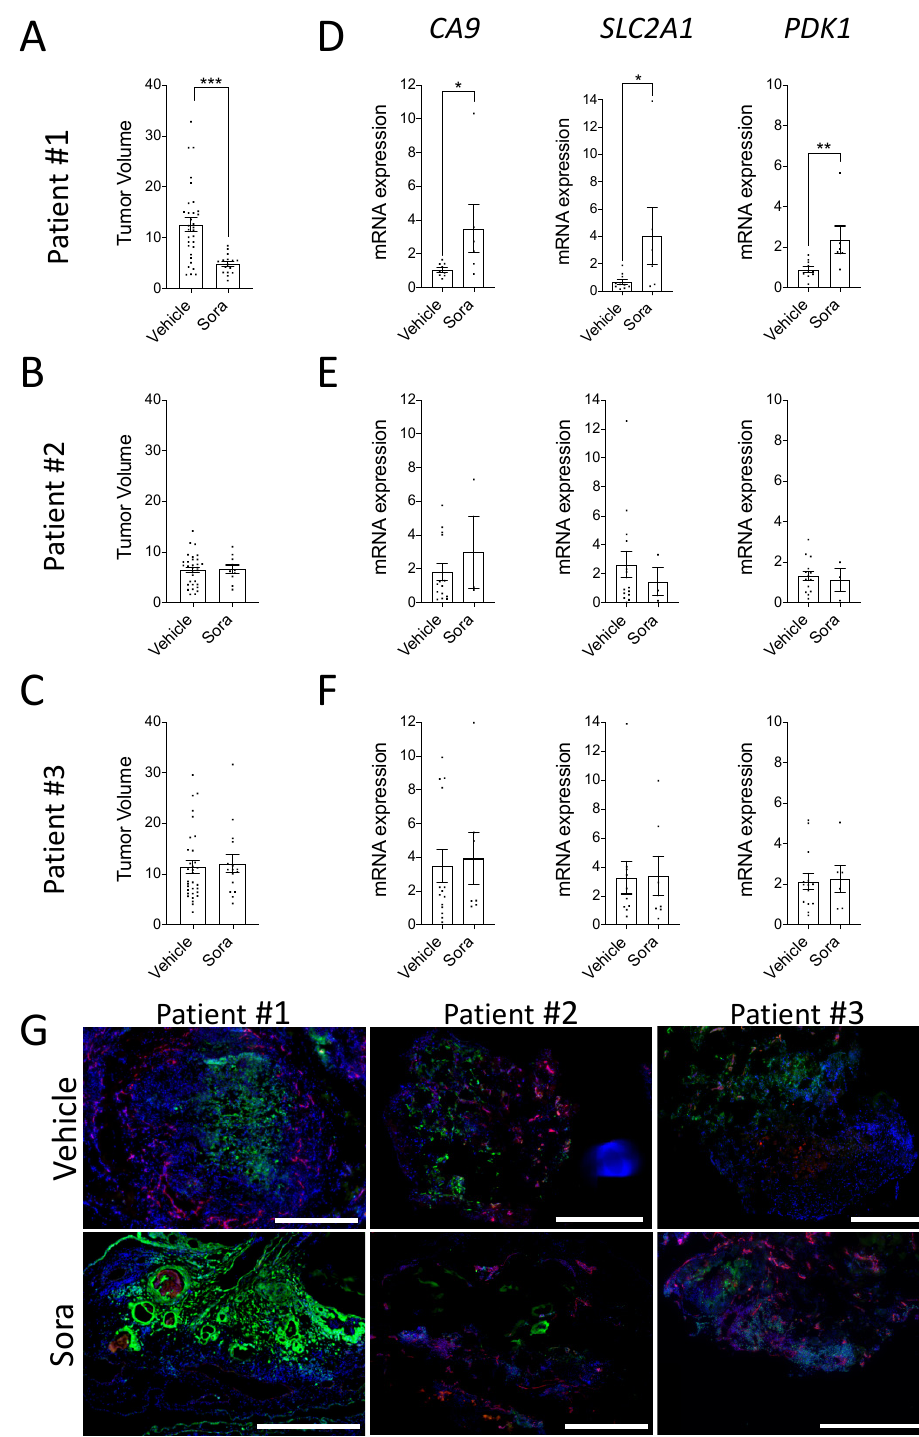
Figure 4. ( A – G ) Tumor fragments from human clear cell Renal Cell Carcinoma (ccRCC) patients were implanted onto the CAM and Sorafenib (Sora) or DMSO (vehicle) was added topically to the tumors every day. ( A – C ) Tumor volumes were calculated after 7 days of growth as the fold increase in tumor size from T0 to T1. n = 10–33 tumor fragments per group. ( D – F ) mRNA expression of CA9 (CAIX), SLC2A1 (GLUT1), and PDK1 (PDK1) in Sorafenib (Sora) vs. DMSO (Vehicle) treated tumor xenografts is shown for 3 different patients. ( G ) Representative immunofluorescence images showing regions of hypoxia (pimonidazole; green) and vascularization (LCA; red) in DMSO (Vehicle) and Sorafenib (Sora) treated tumor xenografts from patient #1, #2, and #3 are shown. Nuclei were stained with DAPI (blue). Scale bar = 500 µ m. Bars represent the mean ± SEM. The asterisks (*) correspond to p < 0.05 (*), p < 0.01 (**), and p < 0.001 (***), non-parametric t